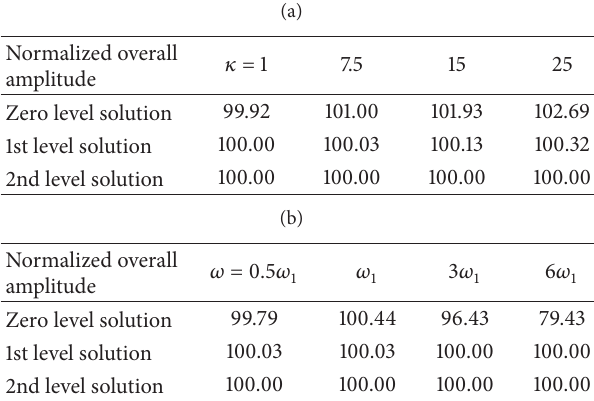
Table 1: (a) Convergence study for various excitation magnitudes, 𝜔 = 1.5𝜔 1 . (b) Convergence study for various excitation frequencies, 𝜅 =